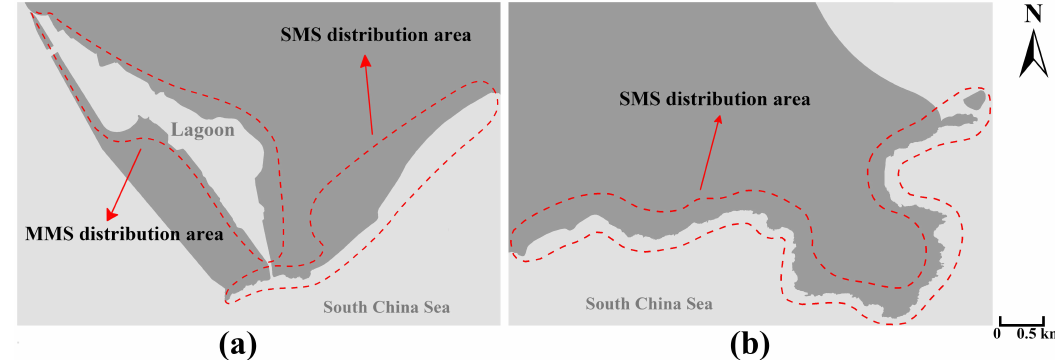
Figure 6. The geographical analysis method used to distinguish the SMS and MMS. ( a ) Geographical analysis in Image 1. ( b ) Geographical analysis in Image